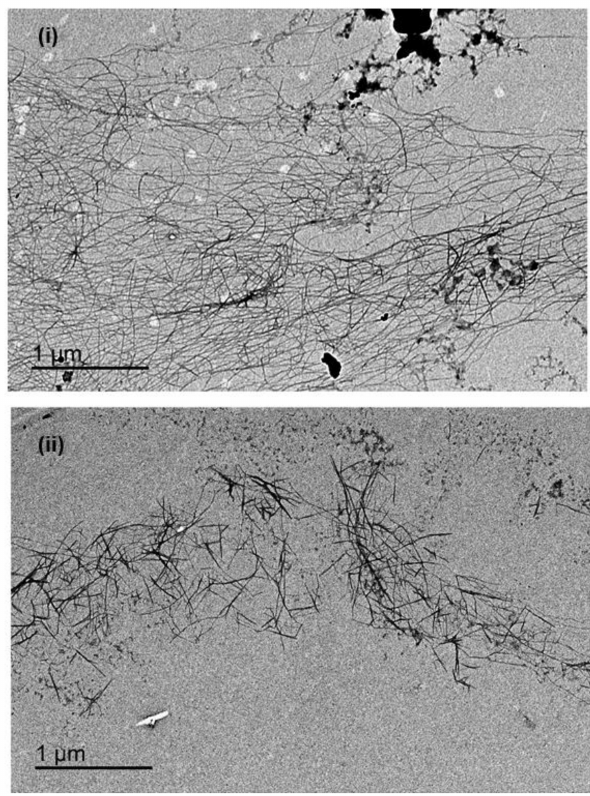
Figure 3. TEM of ( i ) 6CC and ( ii )